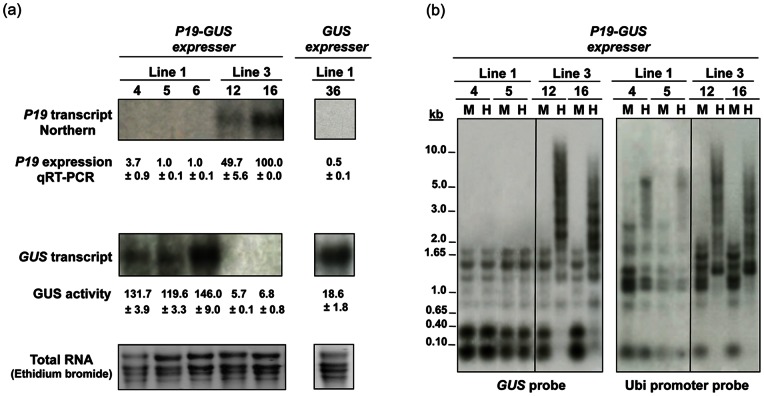
Enhanced expression of the GUS reporter gene by stable co-expression of the TBSV-encoded P19 suppressor in transgenic sugarcane.(a) Relative abundance of P19 and GUS transcripts was determined by northern blot and quantitative RT-PCR (qRT-PCR) analyses in two representative P19-GUS transgenic sugarcane lines co-expressing GUS and P19 (two plants per line). Lines expressing GUS with no suppressor were used as a control. Blots of RNA (15 µg per sample) were probed with radioactively labeled P19 DNA, stripped and then reprobed with GUS DNA. Normalized qRT-PCR P19 expression levels of the P19-GUS lines are reported as a percentage, relative to that of the highest expressing plant. GUS activity (pmoles of 4-methylumbelliferone/min/µg protein) of the P19-GUS lines is also indicated. Values represent three biological samples and three technical repeats, and are reported with the standard error. (b) Methylation status of the coding region and promoter of the GUS reporter gene in the P19-GUS transgenic sugarcane lines. Southern blot of genomic DNA (10 µg per sample) of two representative P19-GUS lines, one non-silenced (Line 1, plants 4 and 5) and one silenced (Line 3, plants 12 and 16), digested with methylation-sensitive HpaII (H), and methylation-insensitive MspI (M), restriction endonucleases, were probed with the GUS gene or the Ubi promoter. Shifts in DNA hybridization fragments indicate methylation.